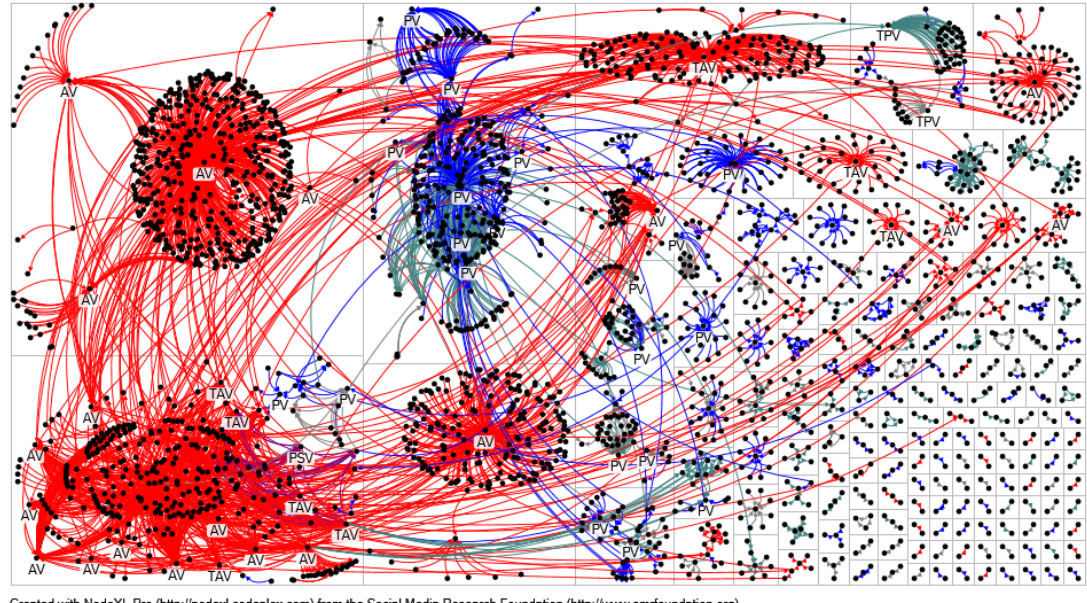
Figure 1. Overall network in October 2016. Notes: The arrows indicate the tweets, the dots indicate the users, and the letters indicate the key actors. Red arrows: anti-vaccine tweets; blue arrows: pro-vaccine tweets; grey arrows: news; green arrows: academic tweets; purple arrows: pro-safe vaccine tweets; AV: anti-vaccine actor; PV: pro-vaccine actor; TAV: ten- dentially anti-vaccine actor; TPV: tendentially pro-vaccine actor.